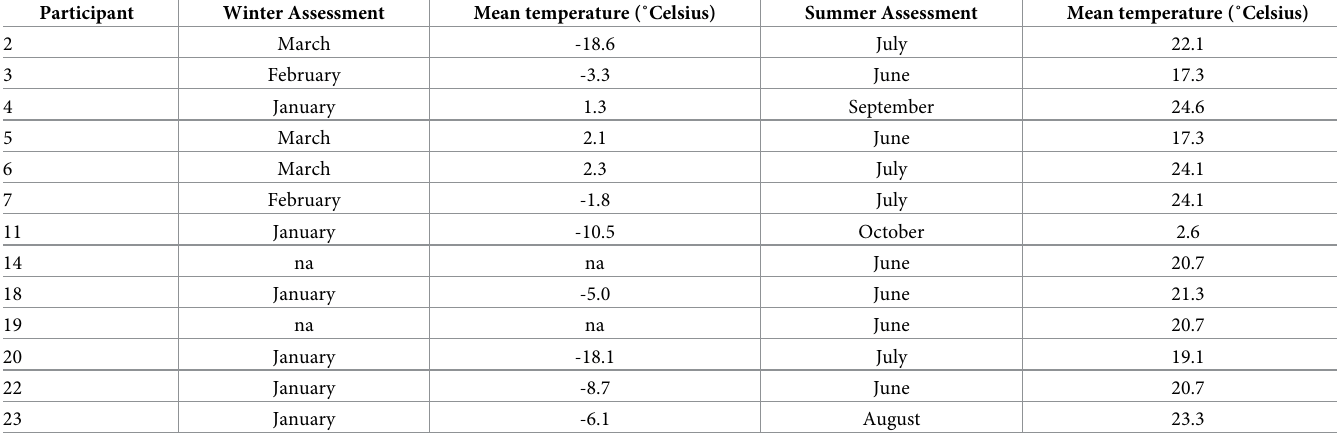
Table 3. Month and temperature of the day each participant completed home based assessment.